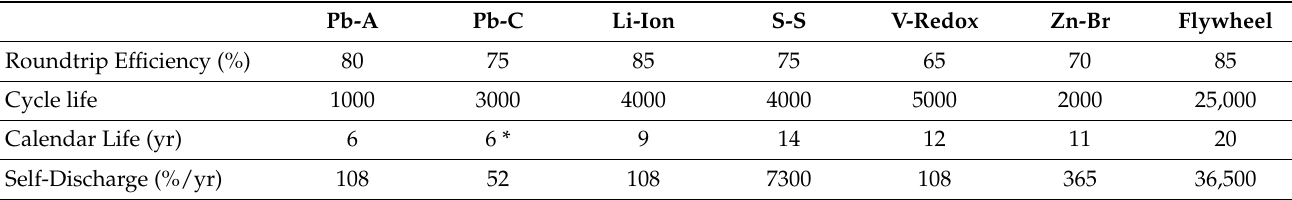
Table 1. Energy storage performance considering four parameters.